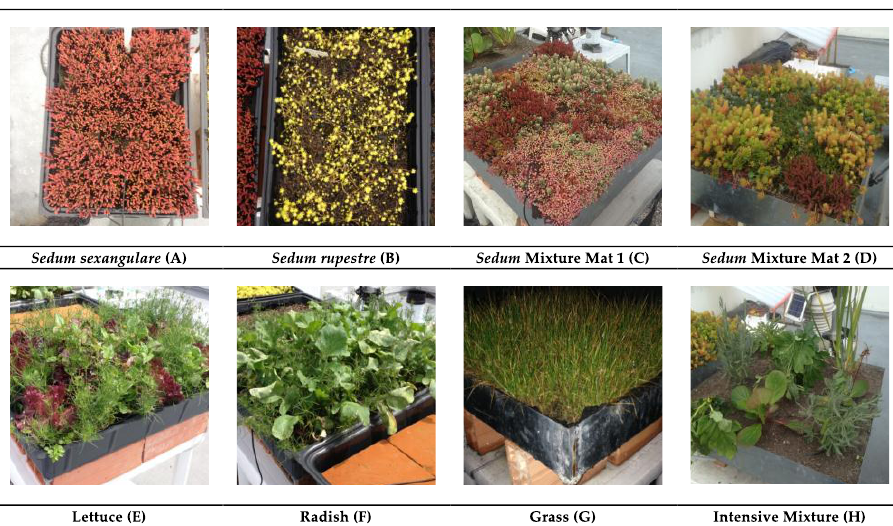
Figure 2. ( A ) Homogeneous configuration of Sedum sexangulare , ( B ) Homogeneous configuration of Sedum rupestre , ( C ) Heterogeneous Sedum mixtures ( Sedum Mixture Mat 1: sexangulare , chatre , album , acre , and kamtschaticum , ( D ) Heterogeneous Sedum mixtures ( Sedum Mixture Mat 2: blue , acre , fino , sexangulare , chatre and oregano ), ( E ) Homogeneous configuration of Lactuca sativa (lettuce), ( F ) Homogeneous configuration of Raphanus sativus (radish), ( G ) Homogeneous configuration of grass, and ( H ) Heterogeneous mixture of Dietes iridioides (water lily), Bergenia cordifolia (bergenia) and Lavanda dentate ( lavender) (Intensive Mixture).